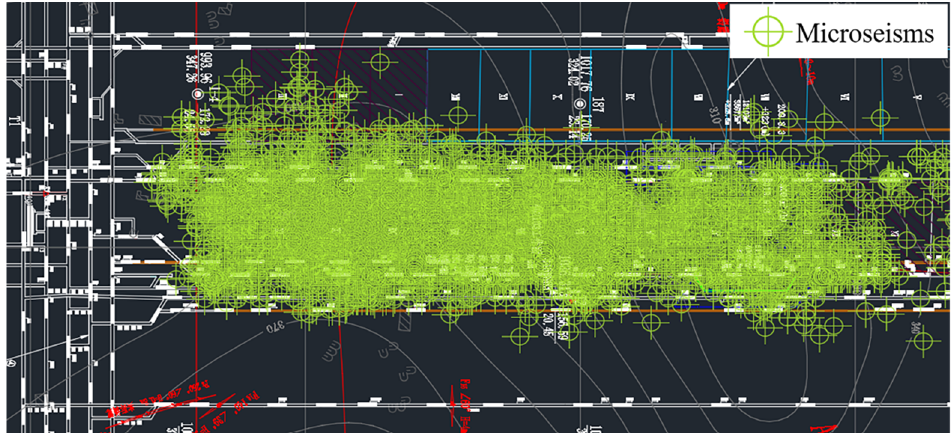
Figure 6. Distribution of microseisms on working face.